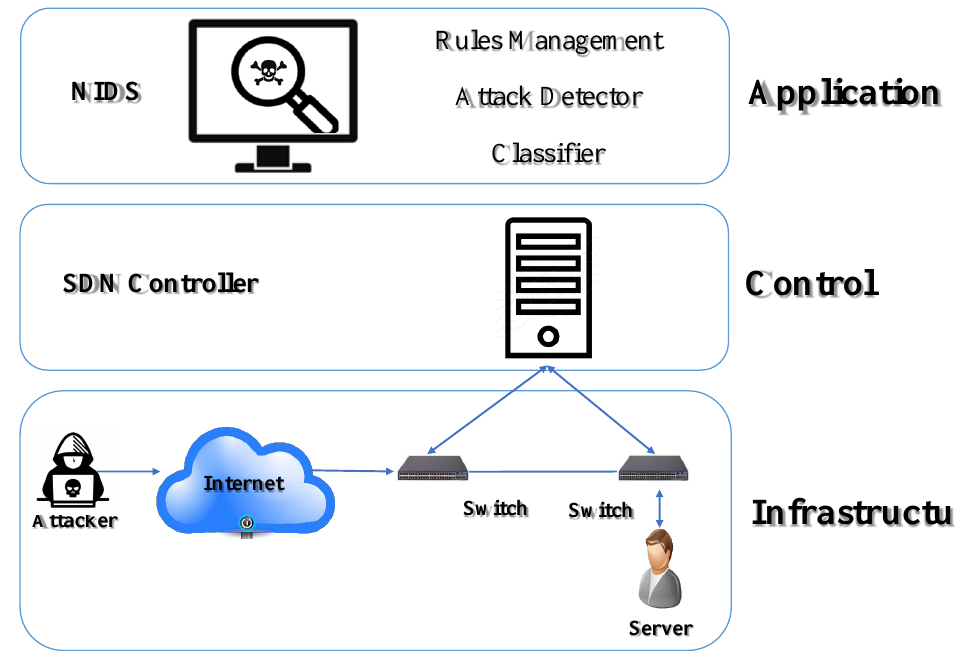
Figure 1. Proposed System Architecture consists of three main layers: the application layer, which contains the Rule management system and NIDS; the control layer contains the SDN controller, while the infrastructure layer includes the switches, servers and the attacker that may exist in one of those